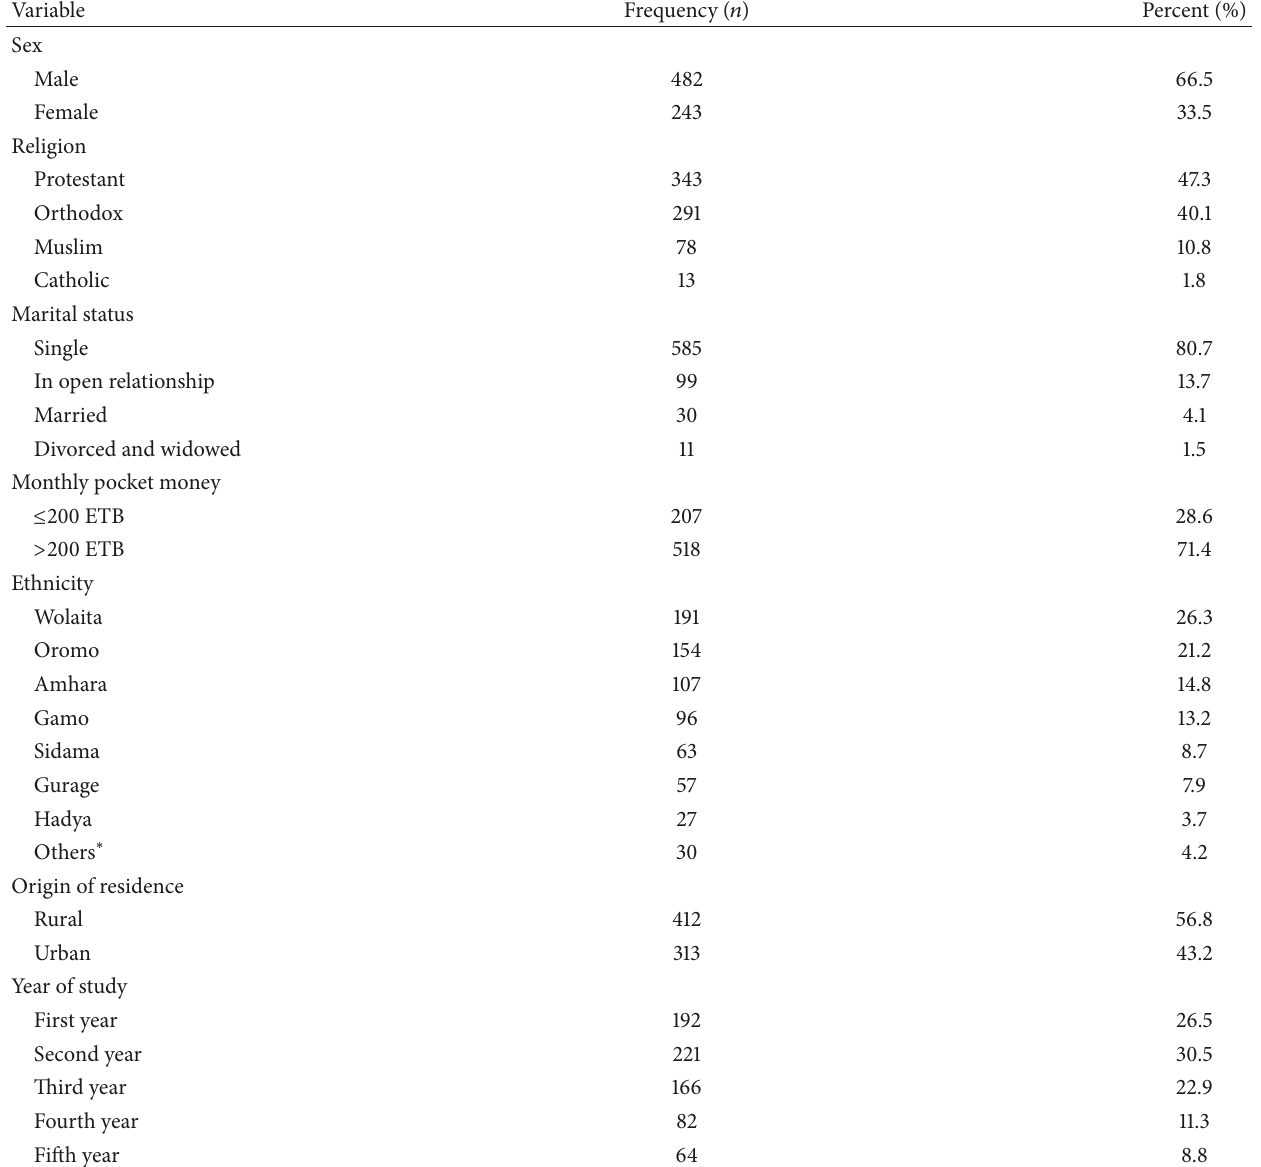
Table 1: Sociodemographic characteristics of Wolaita Sodo University students,